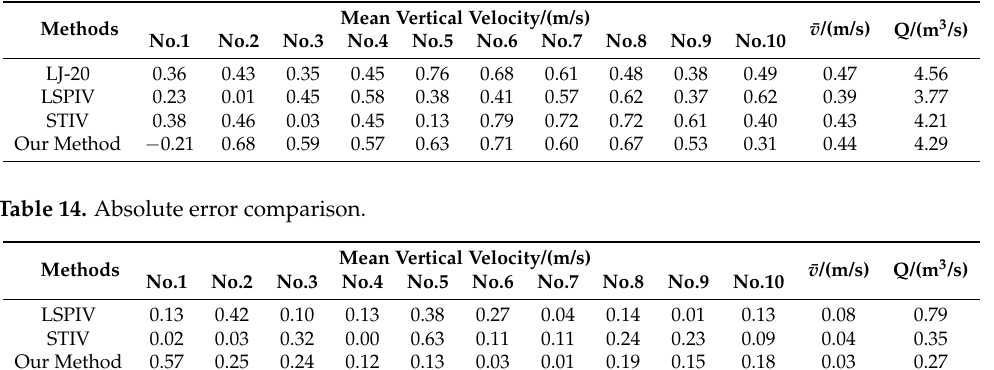
Table 13. Comparison of measurement results by different methods.